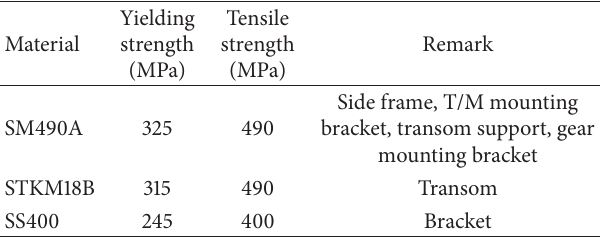
Table 2: Mechanical